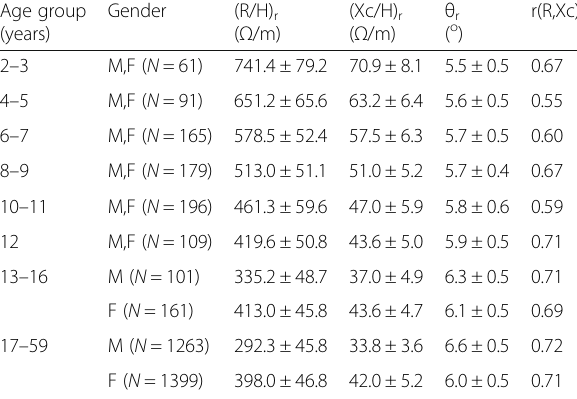
Table 1 Means ±2 standard deviations of bioelectric parameters per height unit for apparently healthy pediatric individuals, by gender and age